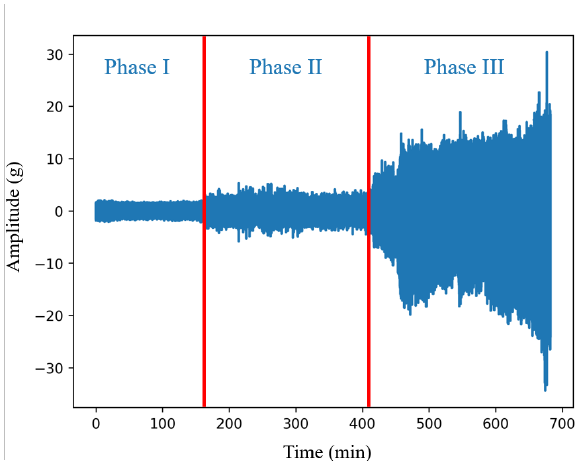
Figure 4. Full life cycle vibration signals of XJTU-SY